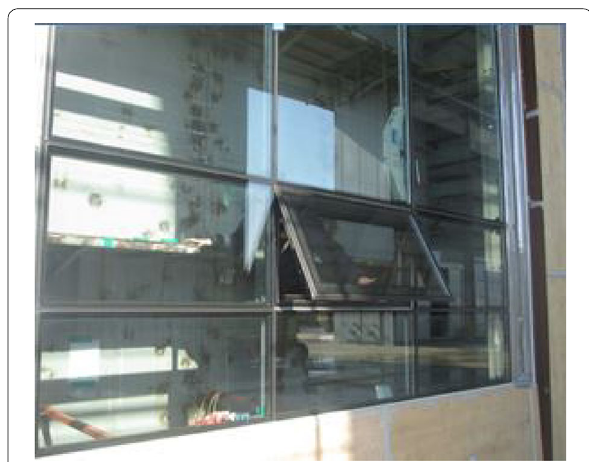
Fig. 7 Vent operation and air tightness performance test.